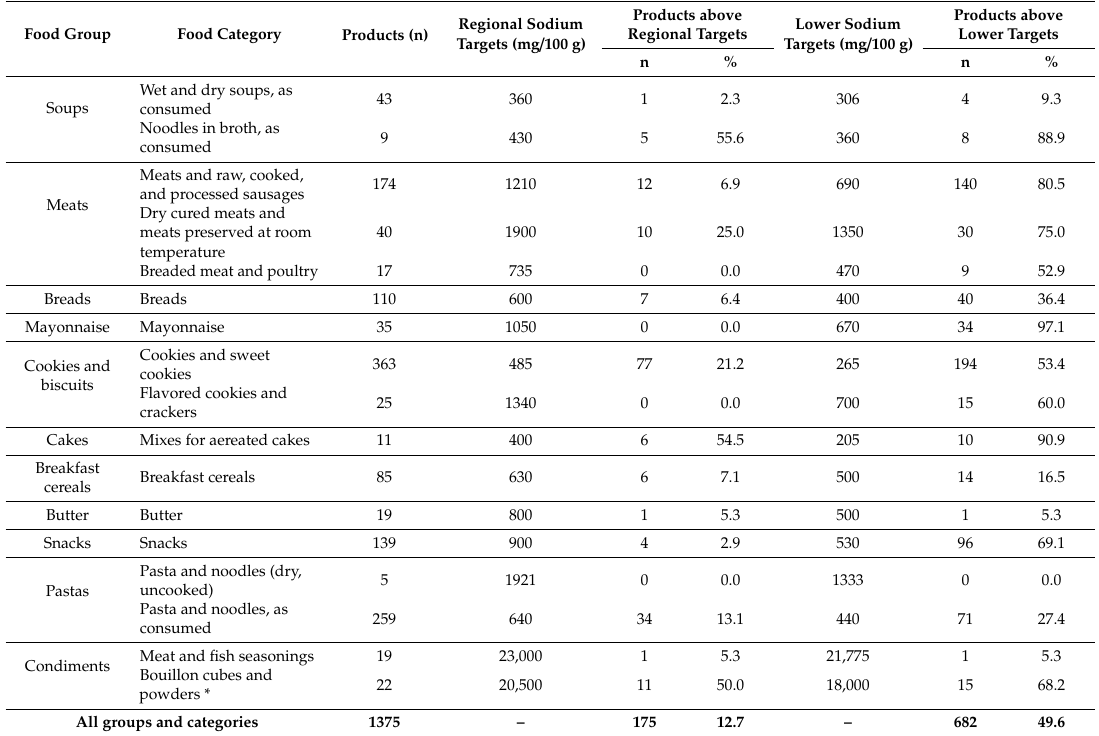
Table 3. Comparison of sodium content in food groups and categories with the 2015 sodium reduction regional and lower targets (n